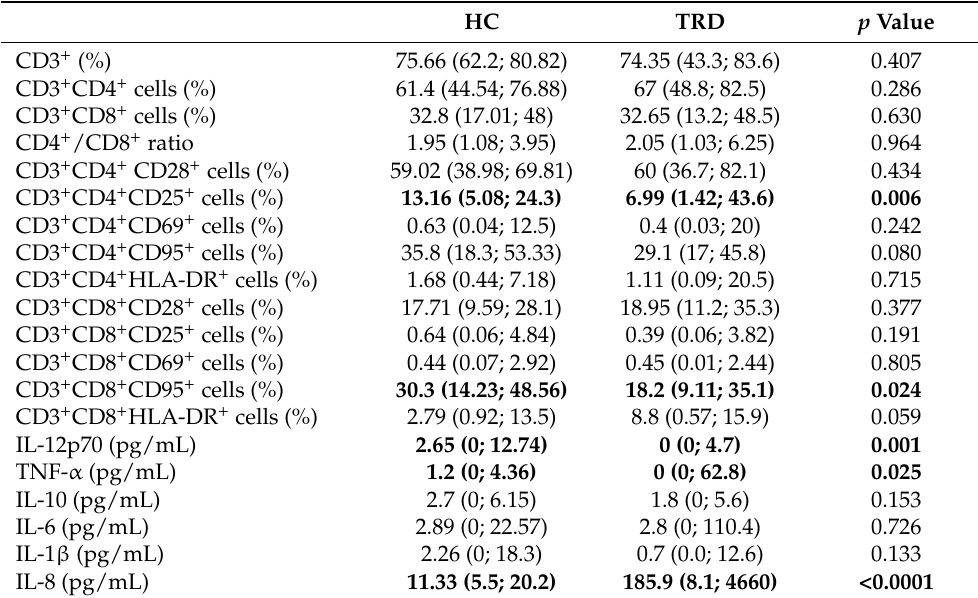
Table 2. Comparison of T-cell subpopulations and cytokine levels between TRD patients and healthy people.